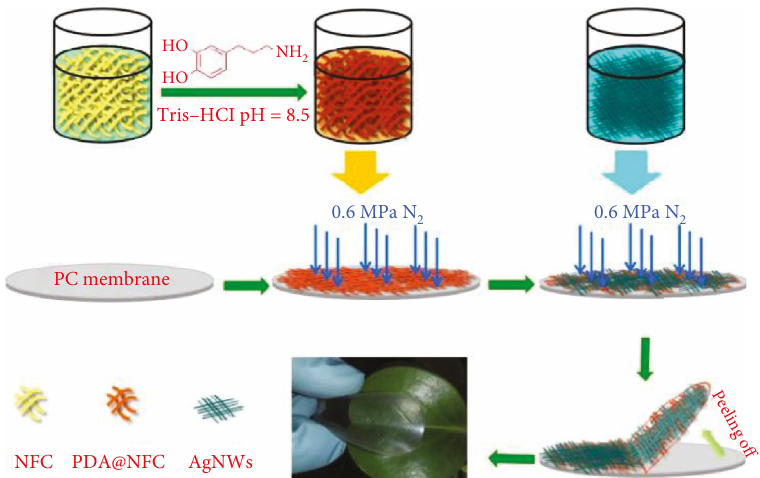
Figure 13: Preparation of polydopamine modi fi ed nanopaper. A solution of cellulose nano fi bres (yellow) is additivated with dopamine at controlled pH. After polymerization, the solution turns brown. A polydopamine-cellulose nanopaper is produced by the fi ltration method. Using the same method, a thin AgNW (blue-green) conductive layer is deposited on the surface of the PDA nanopaper. Reproduced from reference [49] with permission from the Royal Society of Chemistry.